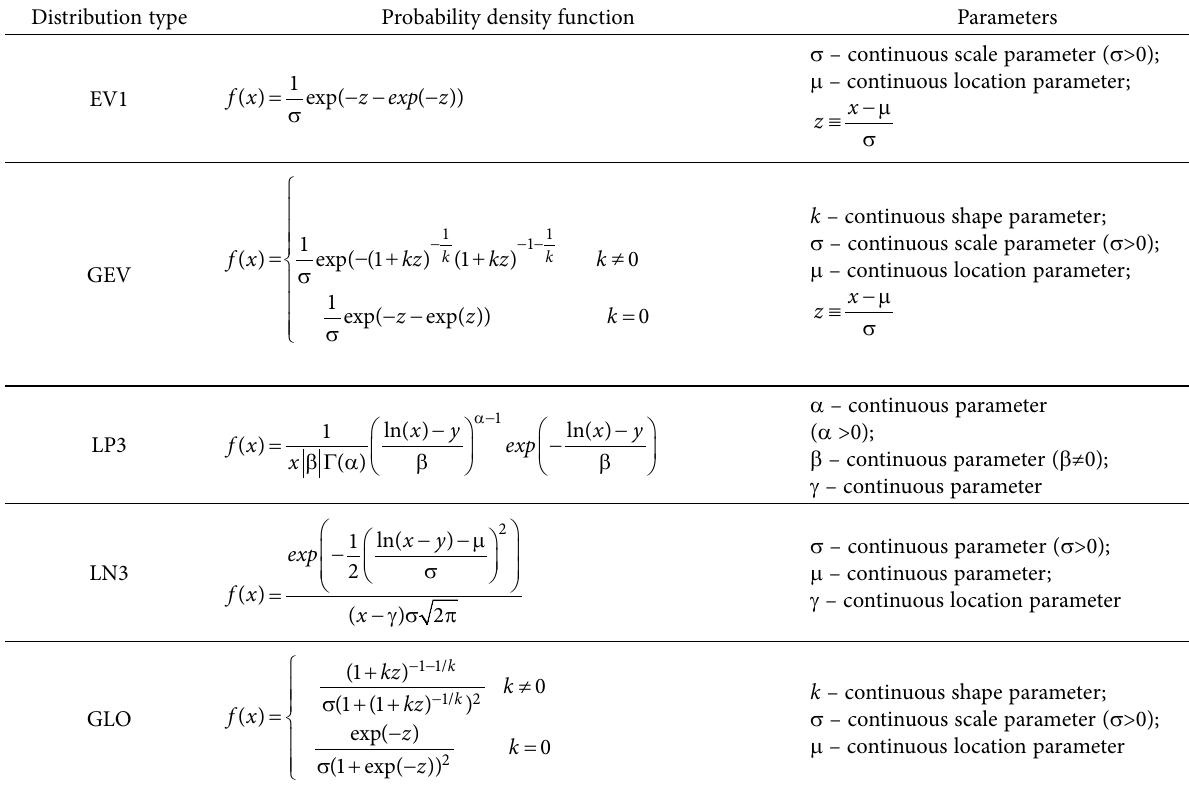
Table 3. Probability density functions of the used